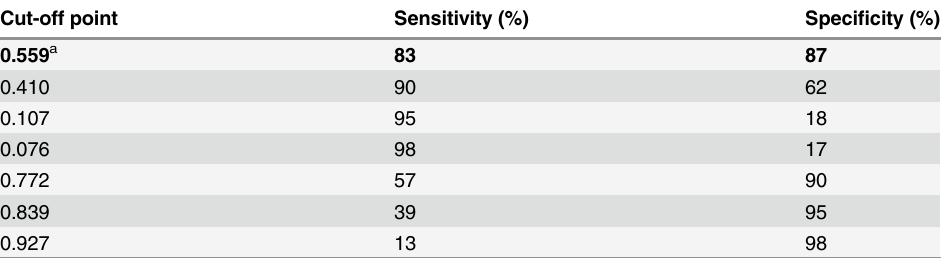
Table 6. Diagnostic performance of the panel composed off CAL+sCD26+EGF+gender+age. Cut-off